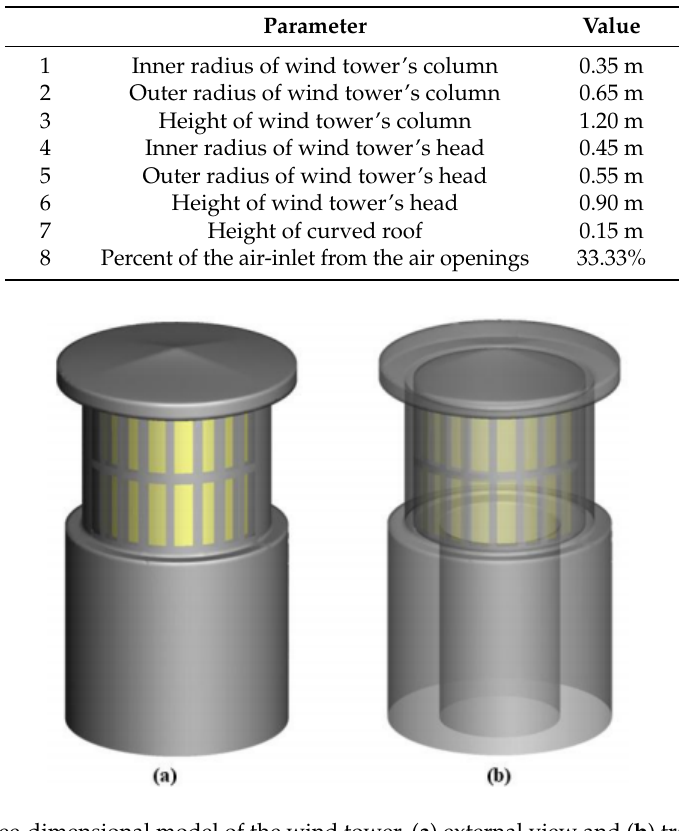
Figure 7. A three-dimensional model of the wind tower, ( a ) external view and ( b ) transparent view.